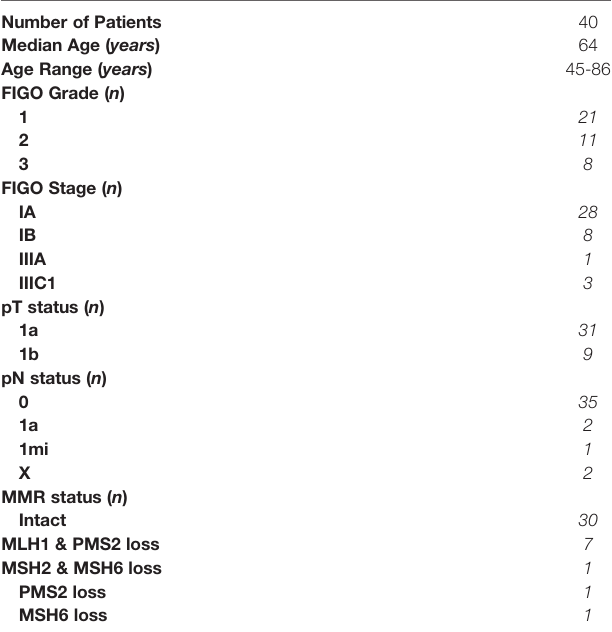
TABLE 1 | Endometrial cancer patient